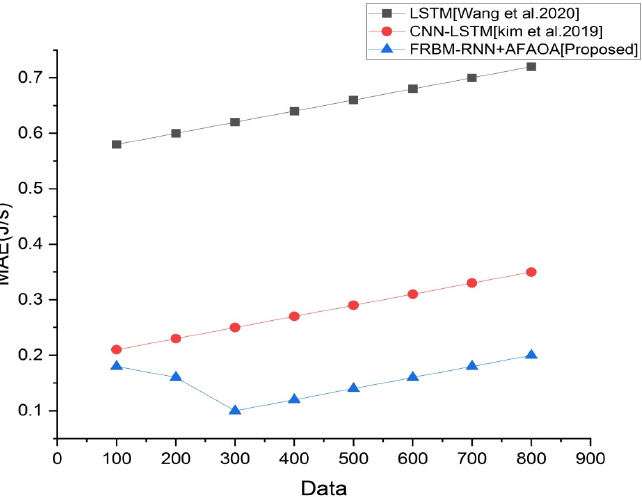
Energies 2022 , 15 , x FOR PEER REVIEW Figure 6. Graphical analysis of various models based on RMSE [Source: Author]. Figure 6. Graphical analysis of various models based on RMSE [Source: Author].